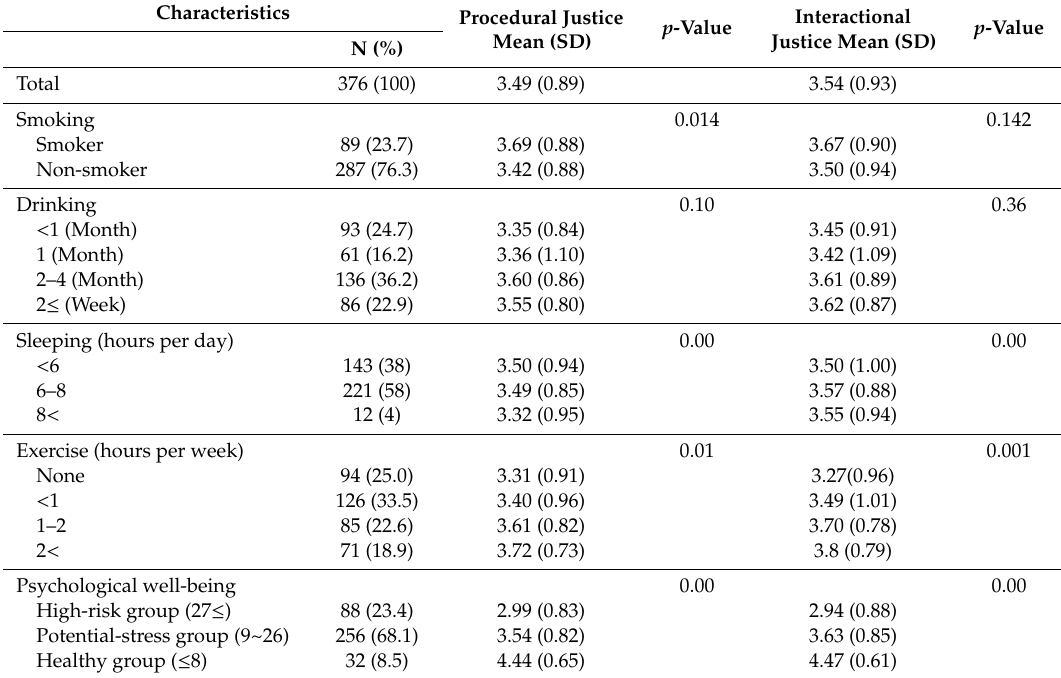
Table 2. Mean values of procedural justice and interactional justice by lifestyle factors.